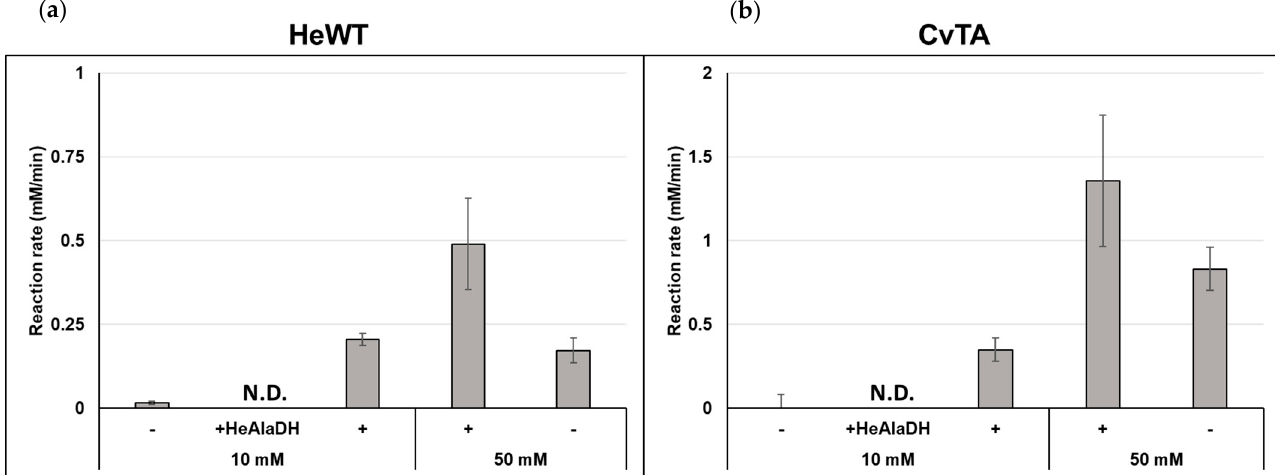
Figure 2. Reaction rate for the amination of vanillin. In the graphs on the left ( a ), the comparison between the transaminase alone ( − ), combined with the alanine dehydrogenase (+HeAlaDH) or the whole assembled system (+) are reported. On the right ( b ), the comparison of the reaction rate at 10 and 50 mM scale with different equivalents of the amino donor is depicted. Reactions were monitored for the first two hours. The reaction rate was estimated on the linear range. Reactions were performed with 2 mg/mL of TA, 1 mg/mL of HeAlaDH, 1 mg/mL CbFDH with 10 or 50 mM of vanillin, 10 or 50 mM of L-alanine, 100 mM ammonium formate, 0.1 eq. of NAD + in 100 mM phosphate buffer pH 8 with 10% DMSO. N.D. refers to not detected.